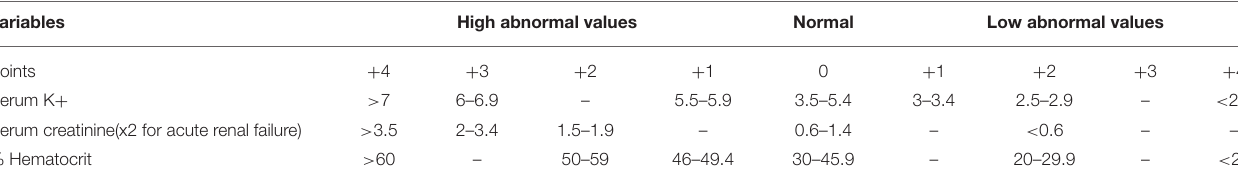
TABLE 2 | Simplified Fournier’s gangrene severity index (SFGSI): > 2 = High risk patients; ≤ 2 = Low risk patients. Variables High abnormal values Normal Low abnormal